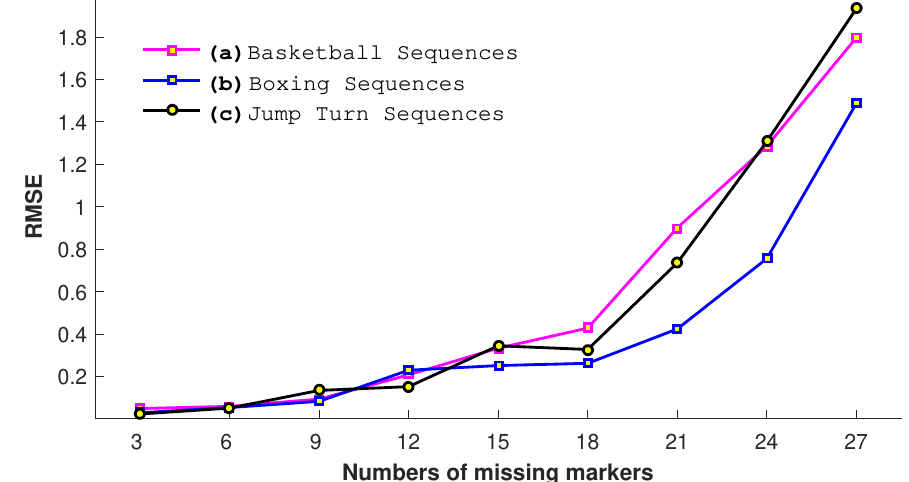
Figure 14. The impact of the number of missing joints in terms of